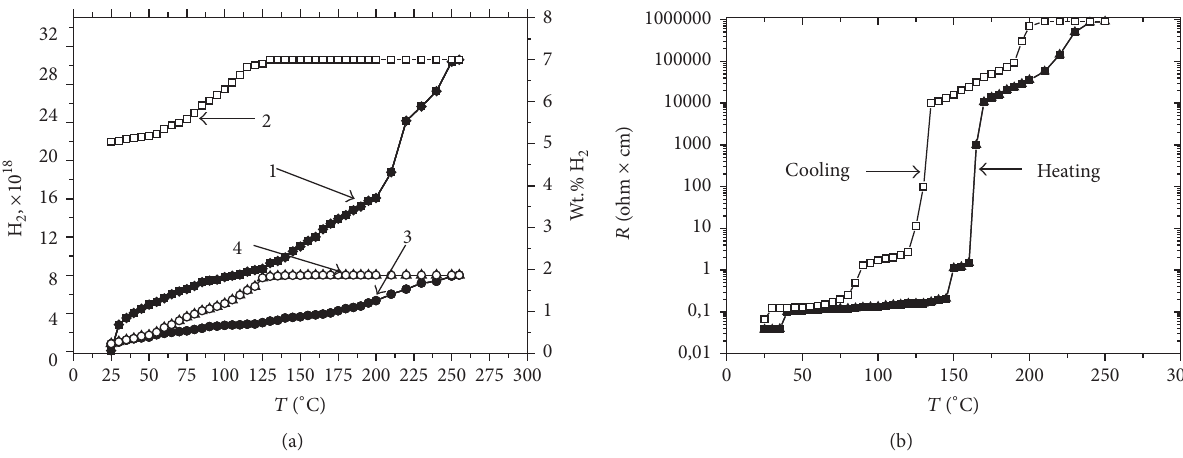
Figure 8: The relationship of the change in the hydrogen amount in the chamber during heating (1) and cooling (2) of VN 𝑥 -H 𝑦 film; the repeated heating (3) and cooling (4) (a). The change in the VN 𝑥 -H 𝑦 film resistivity during its heating and cooling